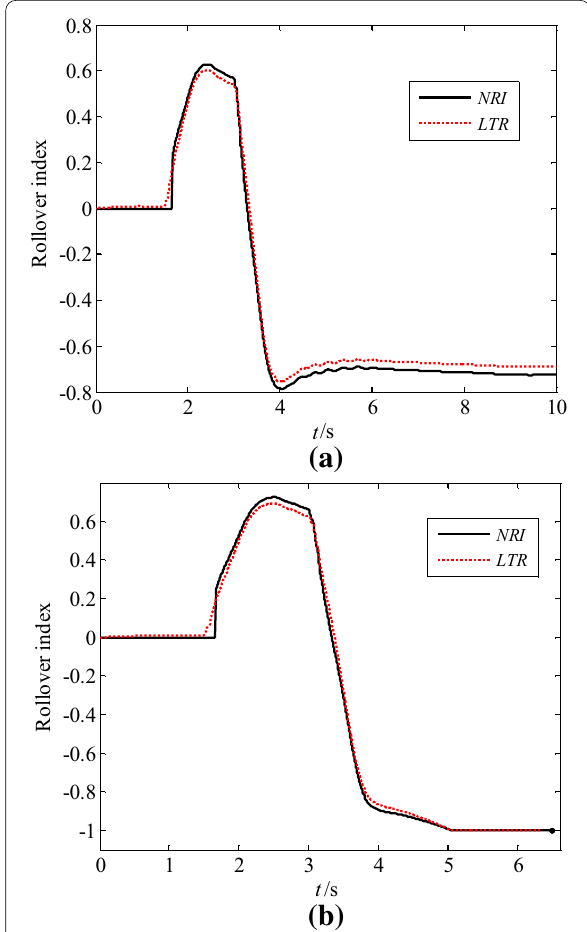
Figure 3 Comparison between LTR and NRI in Fishhook maneuver: ( a ) u 55 km/h; ( b ) u 65 = =